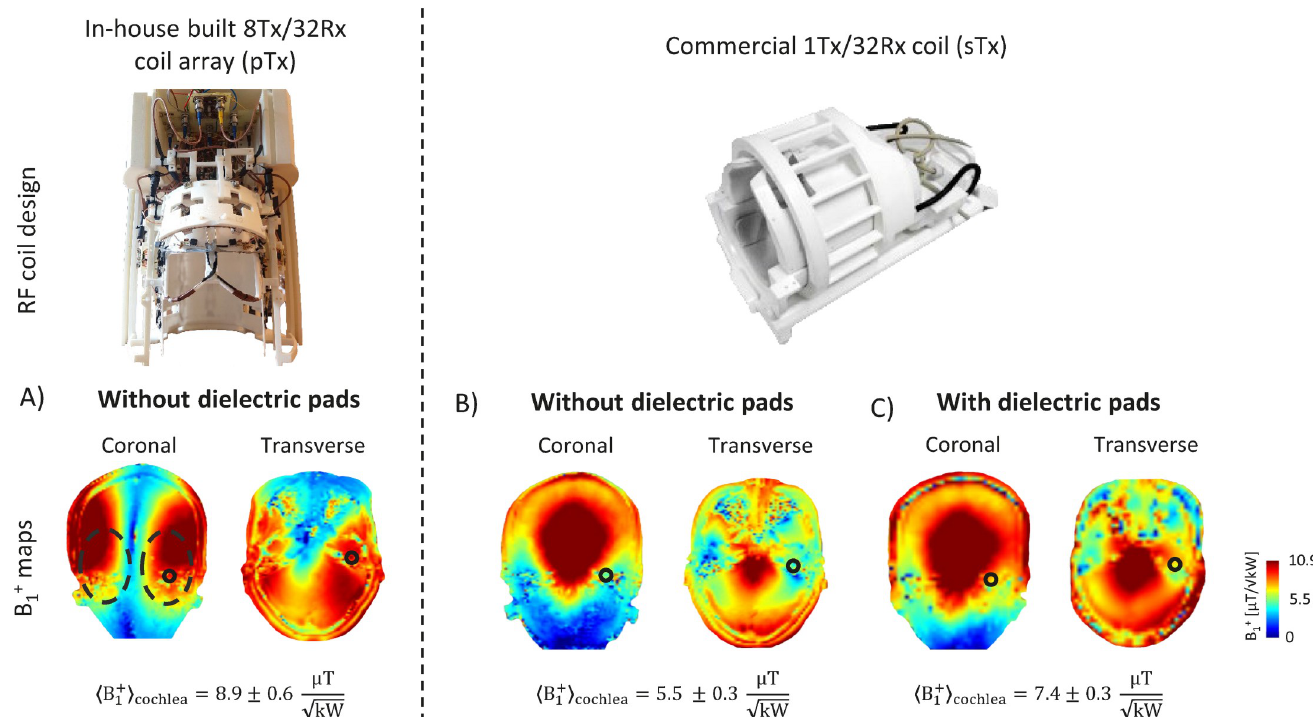
Fig 1. RF coil models and transmit field maps in the inner-ear region. First row: Photos of the 8Tx/32Rx (pTx) coil array (left) and the commercial 1Tx/32Rx (sTx) coil (right). Second row: B 1+ maps shown in coronal and transverse slices centred on inner-ears in: A) pTx mode, B) & C) sTx mode without and with dielectric pads, respectively. In pTx mode, RF phases were optimized over the two lateral sides of the brain (dashed black circles). The mean B 1+ value is given in each situation averaged over a smaller field-of-view encompassing the inner-ear (continuous black circles).